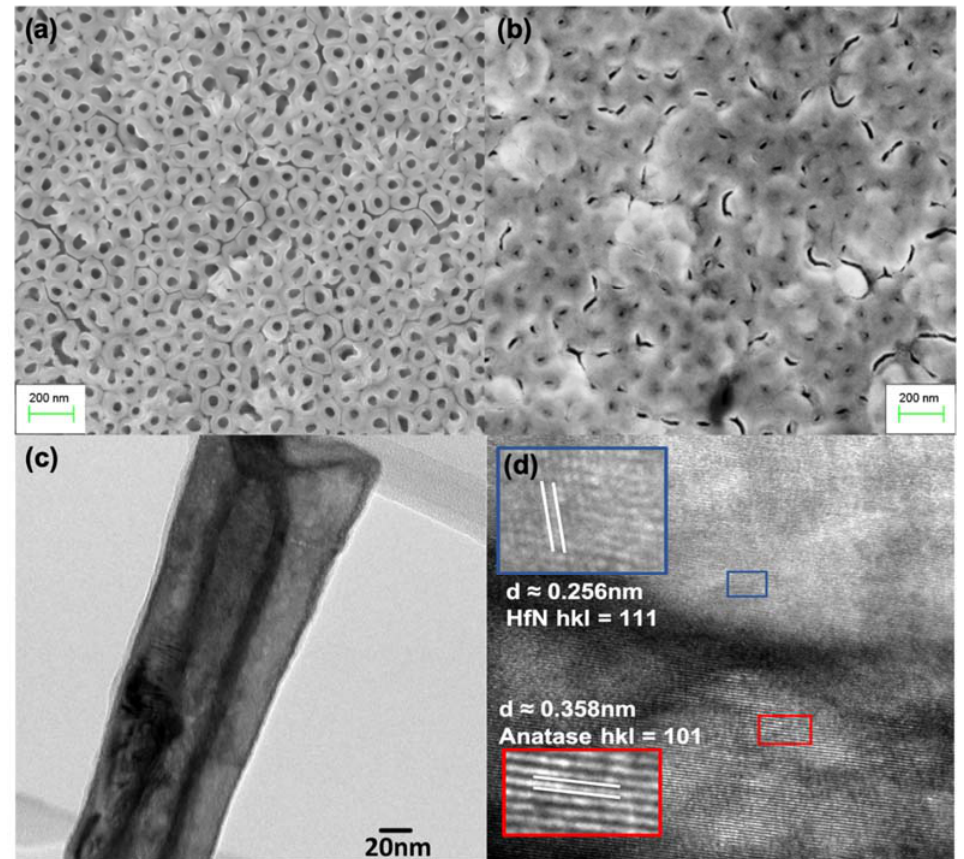
Figure 2. FESEM images for sample before and after ALD HfN coating, ( a ) and ( b ) are top view images before and after HfN coating; ( c ) HRTEM cross ‐ section view image demonstrates the two layers constituting the core–shell nanotube morphology; ( d ) HRTEM image at the HfN and TiO 2 interface showing anatase TiO 2 (101) lattice fringes and HfN (111) lattice fringes.